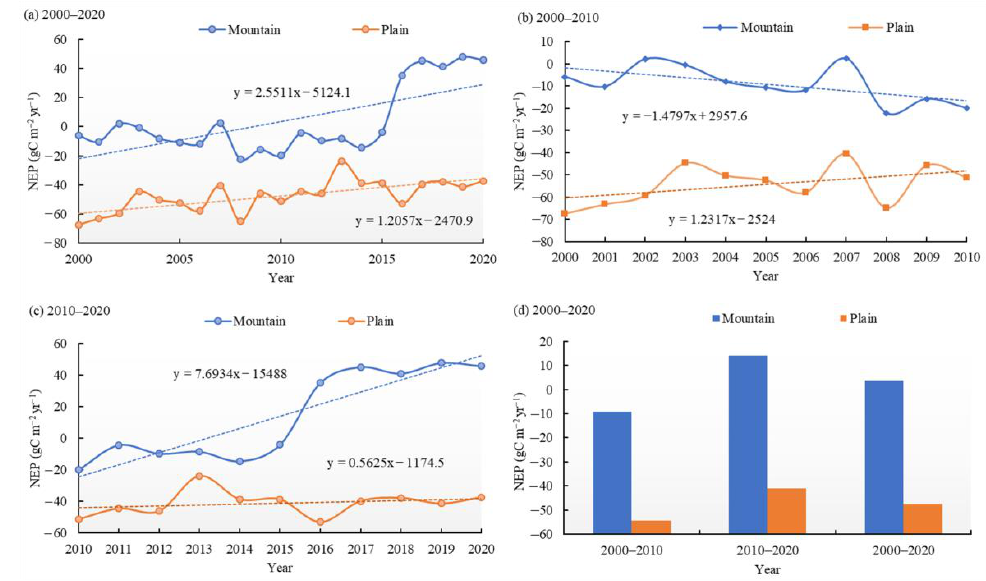
Figure 5. Temporal variations in NEP in the mountains and plains during ( a ) 2000−2020, ( b ) 2000−2010, and ( c ) 2010−2020; ( d ) annual average NEP during 2000−2010, 2010−2020, and 2000−2020. In terms of the dynamic changes of vegetation NEP in mountain and plain areas dur- ing 2000 – 2020 (Figure 6), the NEP in the NXJ mountain region showed the highest increas- ing trend, rising at an average rate of 3.17 gC m − 2 yr − 1 ( p < 0.01). In the mountains of SXJ and HX, the NEP increased at rates of 1.88 and 2.52 gC m − 2 yr − 1 ( p < 0.01), respectively. The NEP in the plains also increased substantially in NXJ and SXJ ( p < 0.01) at a rate of 1.06 and 1.71 gC m − 2 yr − 1 , respectively. In the plain of HX, the increasing rate of vegetation NEP during 2000 – 2020 was 0.32 gC m − 2 yr − 1 . The NEP in the plains of NXJ, SXJ and HX all showed slower trends from 2010 onward (especially since 2015). This is in contrast to the NEP in the mountains, which exhibited high increasing rates of 10.92, 5.16 and 5.13 gC m −2 yr −1 , respectively since 2010. Obvious geographically heterogeneous distributions and changes occurred in vege- tation carbon sinks and sources. Carbon source areas form the majority and are mainly located in plains, which accounts for 54.49% of the total plain area. During 2020, approxi- mately 54.37% of the vegetation NEP in mountains were carbon sinks, whereas 69.81% of the vegetation NEP in the plains were carbon sources. The proportion of carbon sinks of vegetation in mountains increased from 37.43% to 54.37% during 2000 – 2020, and the pro- portion carbon sinks of vegetation in the plains ranged from 19.85% to 30.19% during the same period.